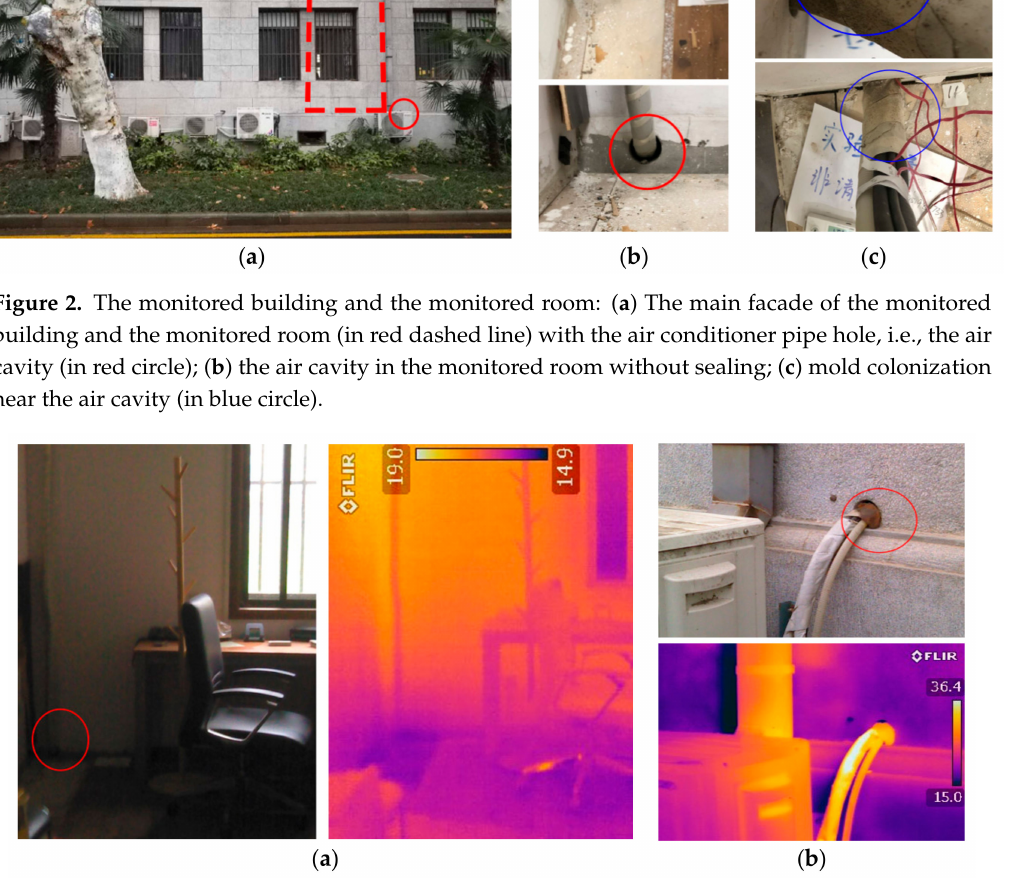
Figure 3. Infrared thermography of the air cavity area (in red circle) viewed from: ( a ) inside and ( b ) outside.